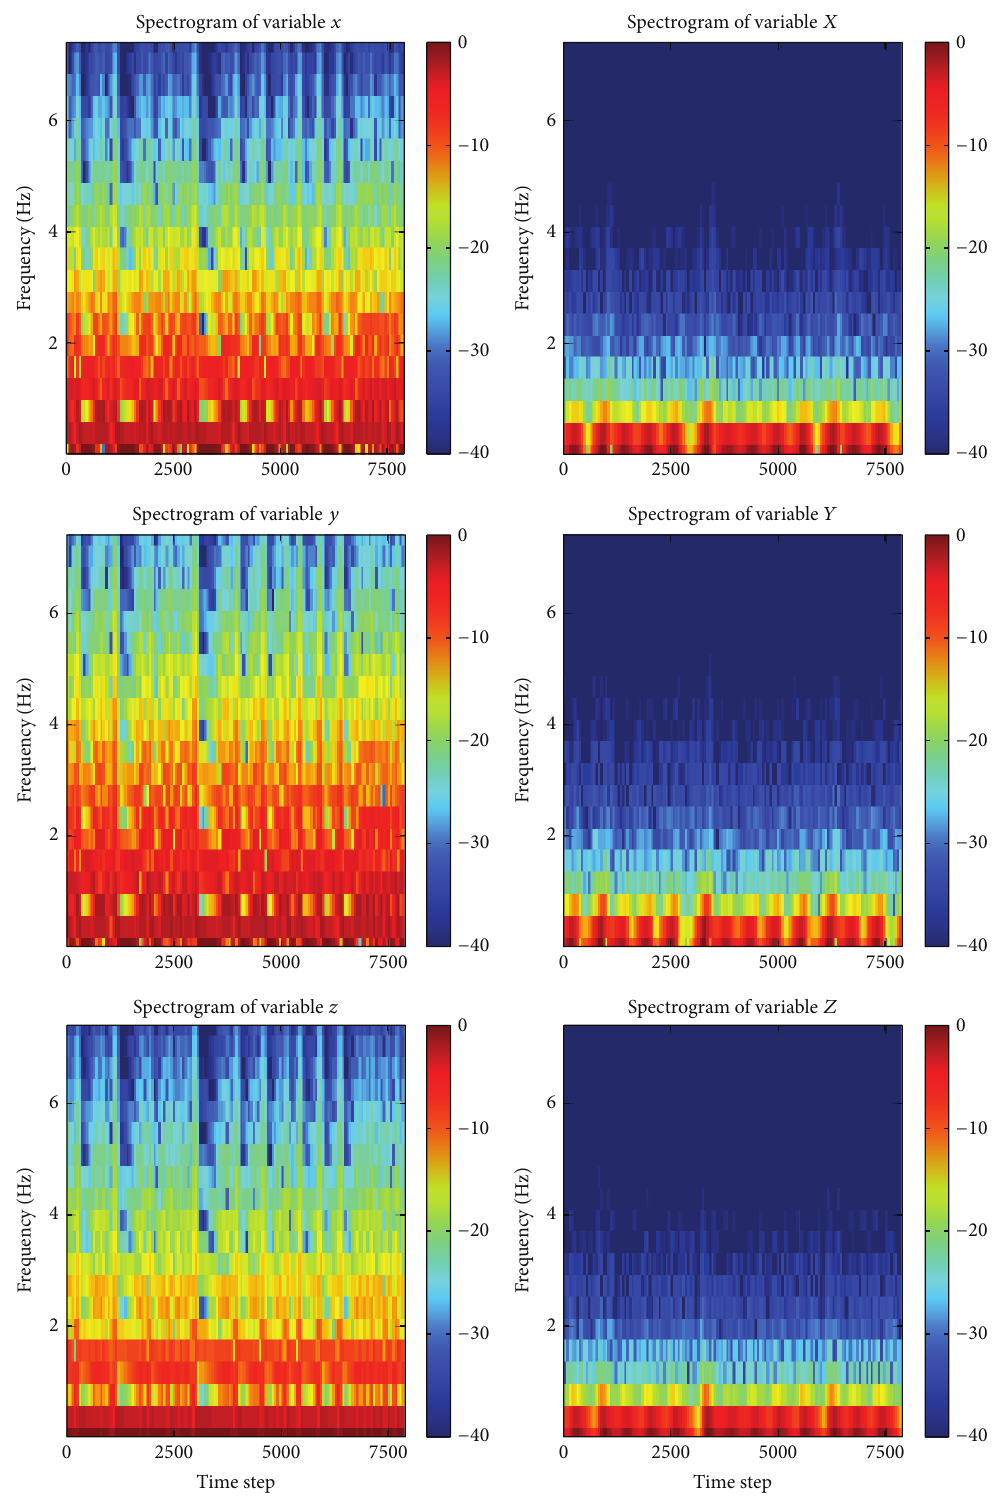
Figure 11: Spectrogram for fast and slow dynamic variables for 𝑐 = 0.15